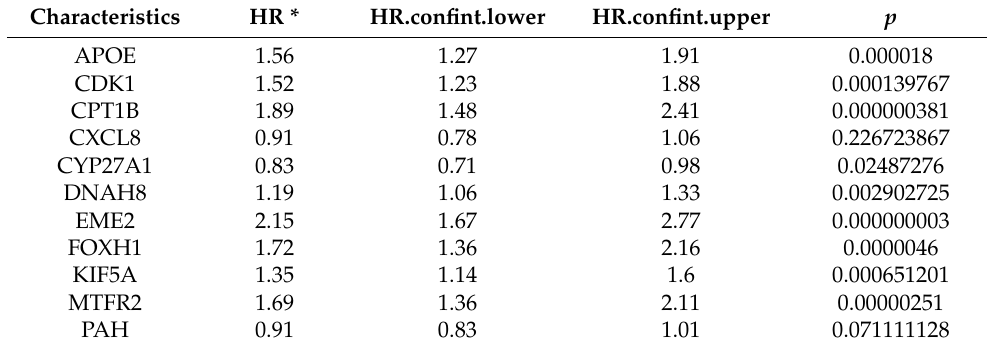
Table 1. Top 9 DE-MR-BCRGs by univariate Cox regression